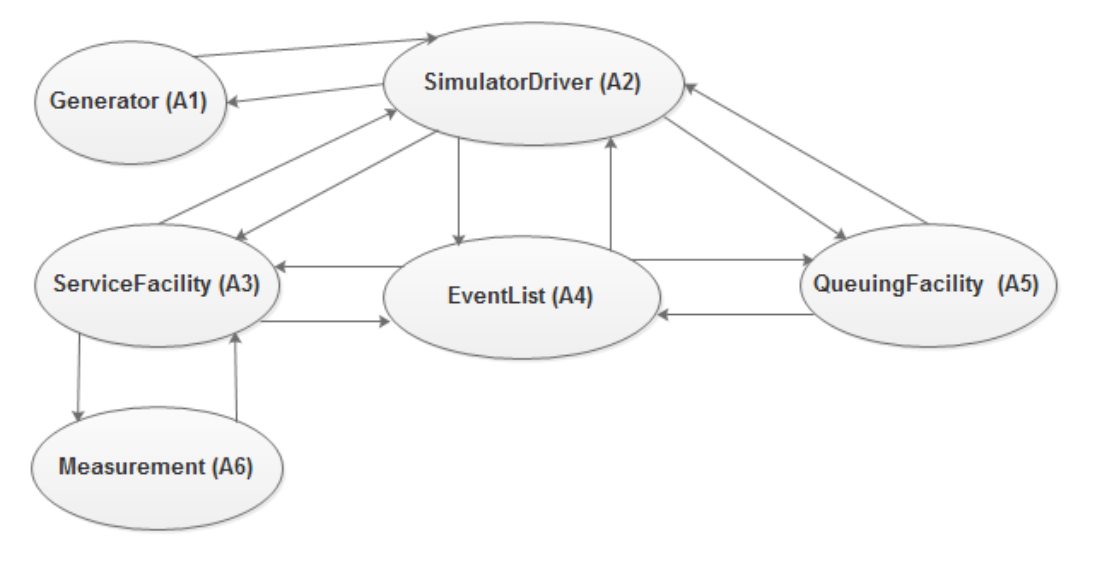
Fig. 5. Graphical representation of